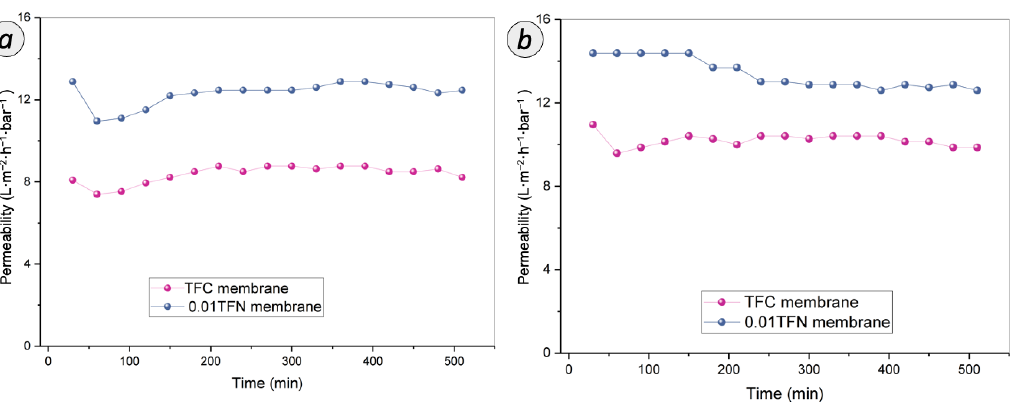
Figure 11. Long-term performances of TFC and 0.01 TFN membranes for the filtration of ( a ) BPA and ( b ) caffeine over duration of 540 min.